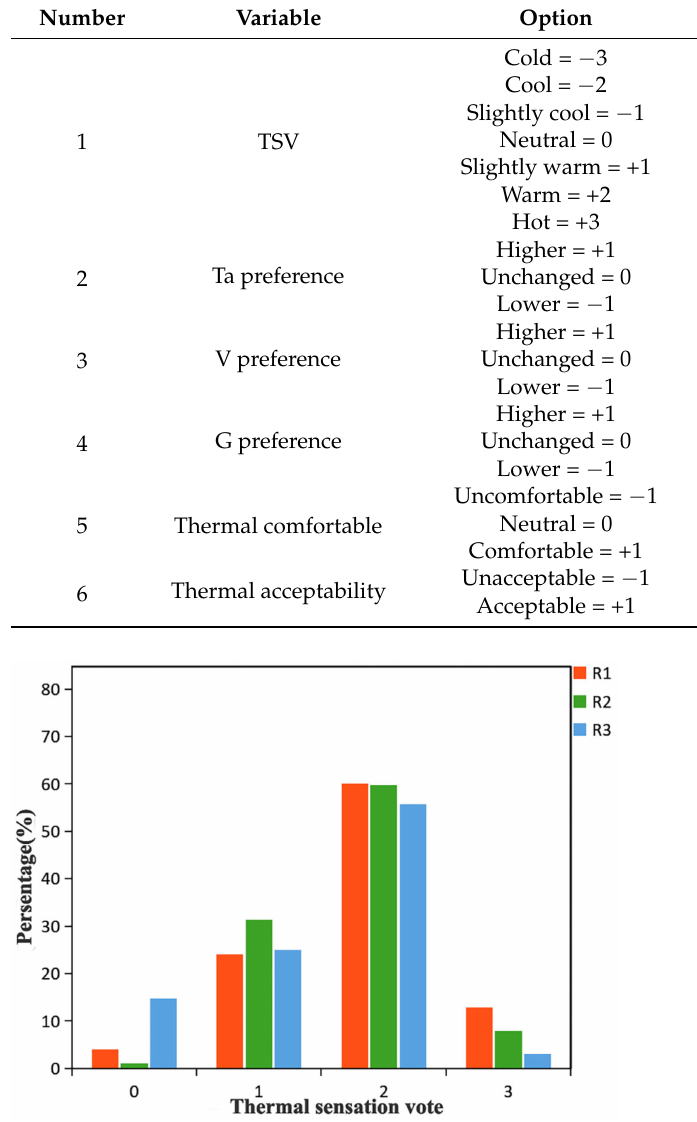
Figure 5. Thermal sensation vote (TSV) in three different measuring